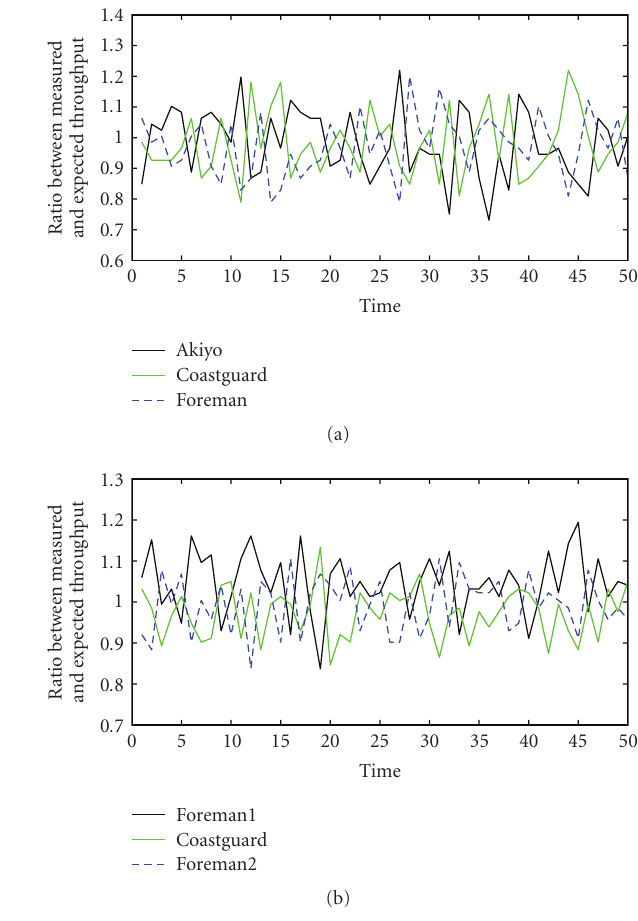
Figure 6: Throughput jitter for each flow for (a) video profiles in Table 1, (b) video profiles in Table